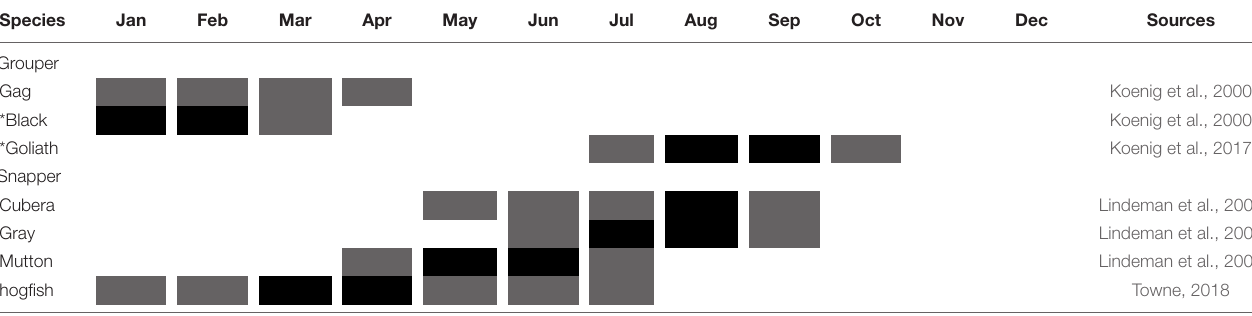
TABLE 4 | Spawning seasonality for study species found in the Southeast Florida Coral Reef Ecosystem Conservation